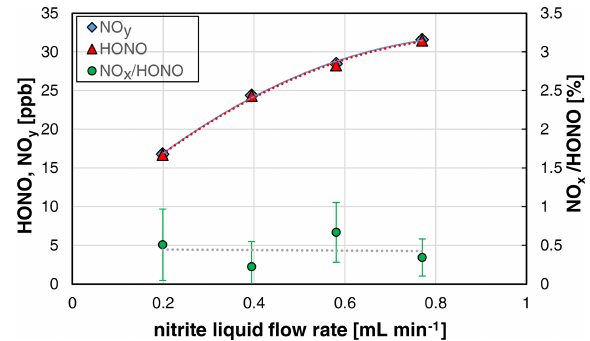
Figure 5. Gas flow rate dependence of NO y , HONO, and the NO x / HONO ratio of the HONO source (NO − T = 15.9 ◦ C, 20rpm, pH = 2.47). The error bars represent the pre- cision errors (2 σ ), which are only visible for the NO x / HONO ratio but smaller than the size of the symbols for HONO and NO y .